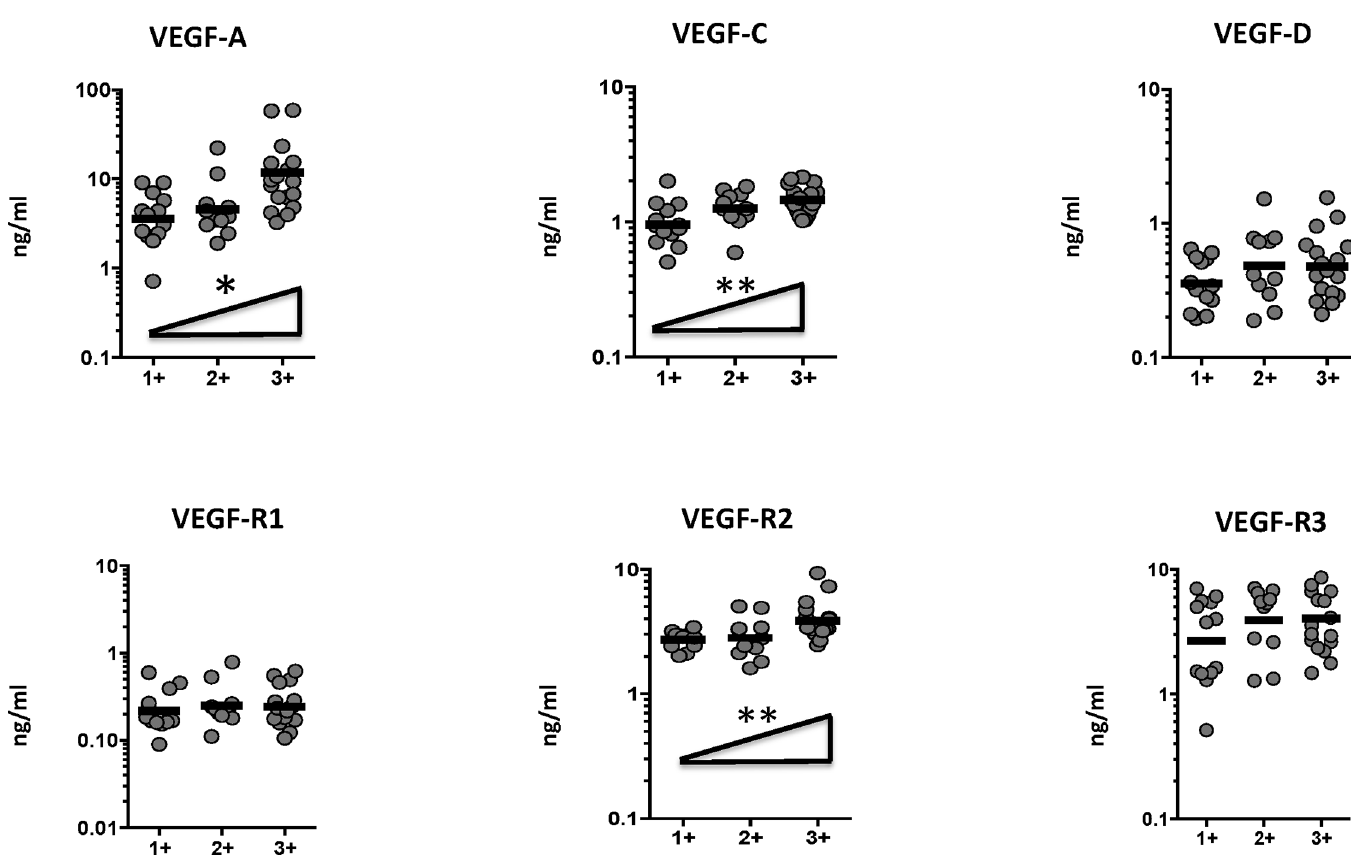
Fig 3. Positive relationship between systemic levels of angiogenic factors and smear grades in PTB individuals. The relationship between the plasma levels of VEGF-A, C, D, VEGF-R1, R2, R3 and smear grades as estimated by sputum smears was examined in all PTB individuals. The data are represented as scatter plots with each circle representing a single individual. P values were calculated using Linear trend post-test.